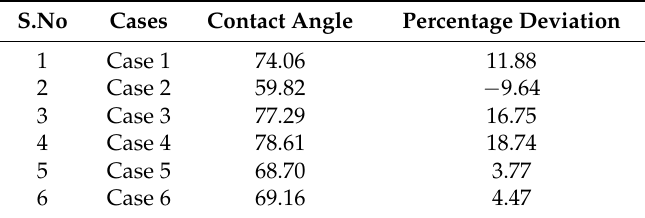
Figure 20. CH 4 ( a ) and CO 2 ( b ) volumetric gas consumption during the hydrate formation. Induction time was more visible in the case of methane than CO 2 due to the exponential hydrate formation in the latter. Table 3. Contact angles calculated from the considered cases.